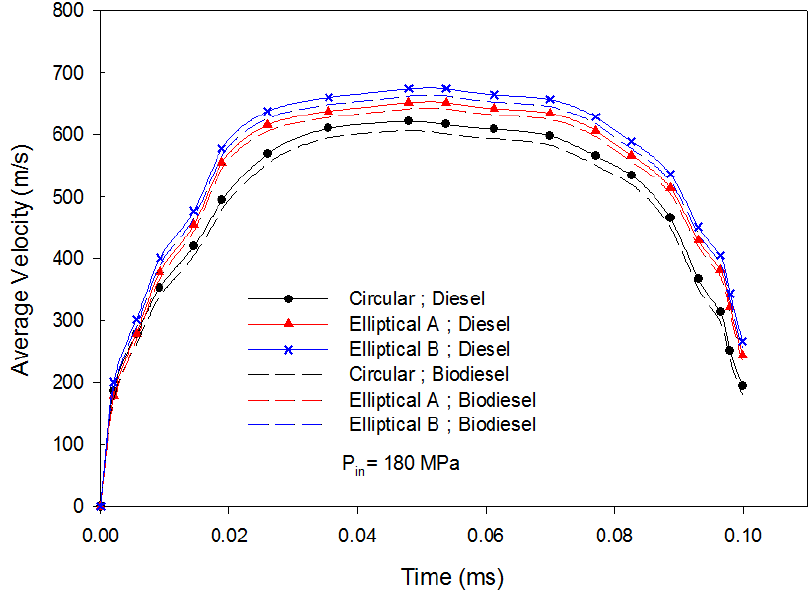
Figure 13. Outlet Average liquid velocity under 180 MPa pressure for different type of nozzle shape and fuel.